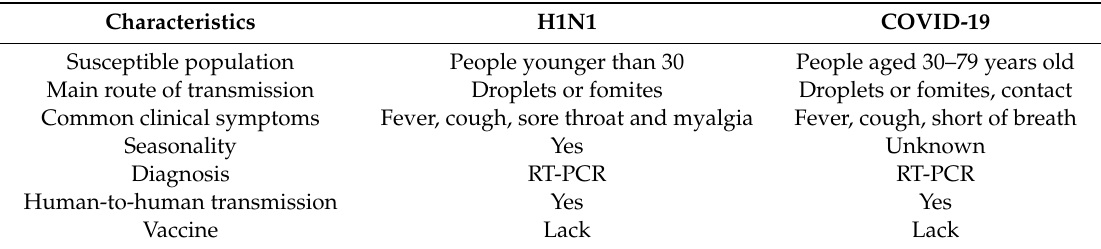
Table 1. Characteristics of the H1N1 swine influenza and